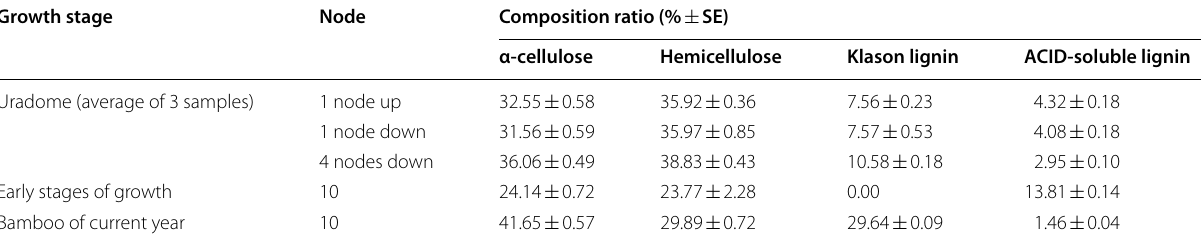
Comparison of the compositional ratios of the major components at each growth stage. Bar: